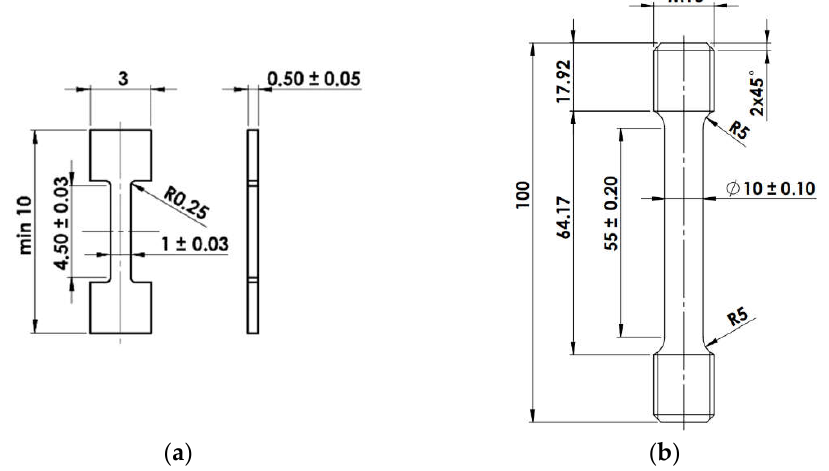
Figure 1. Specimen geometry used for ( a ) mini-tensile test ( b ) standard tensile test.